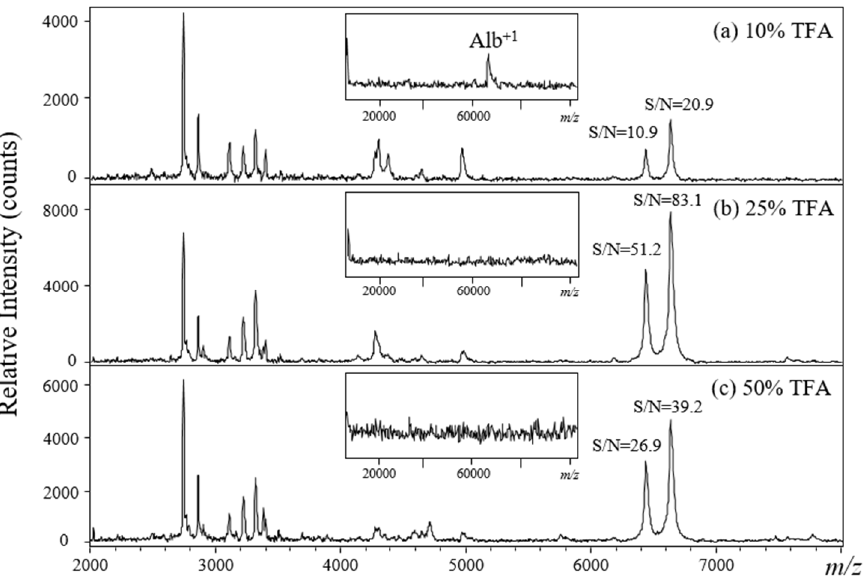
Figure 2. ( a – c ) Positive-ion MALDI mass spectra for plasma samples hydrolyzed with different TFA acid solutions. MALDI matrix: α -CHC in 50% ACN incorporating 0.5% TFA (V sample :V matrix = 1:1).